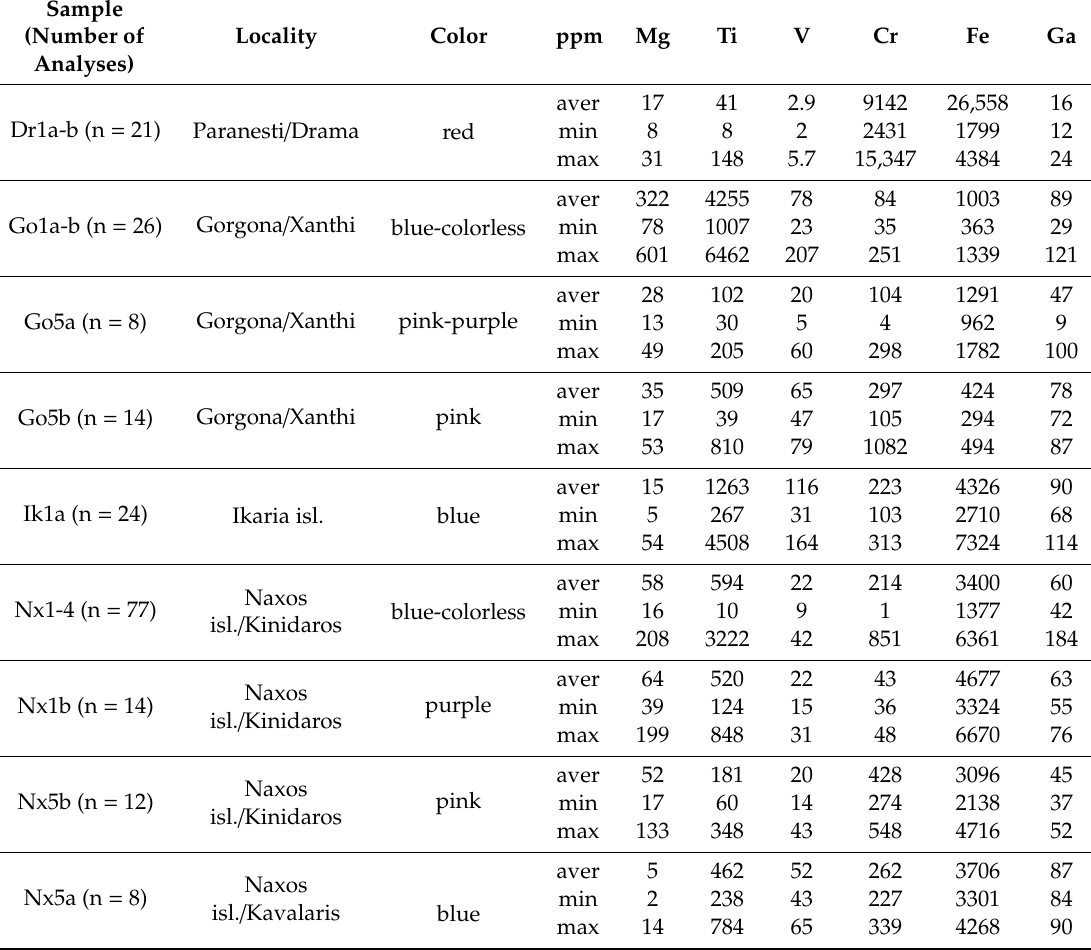
Table 1. Chromophores and key trace elements (Mg and Fe) LA-ICP-MS analyses (ppm) of the Greek corundum crystals (data from Voudouris et al.